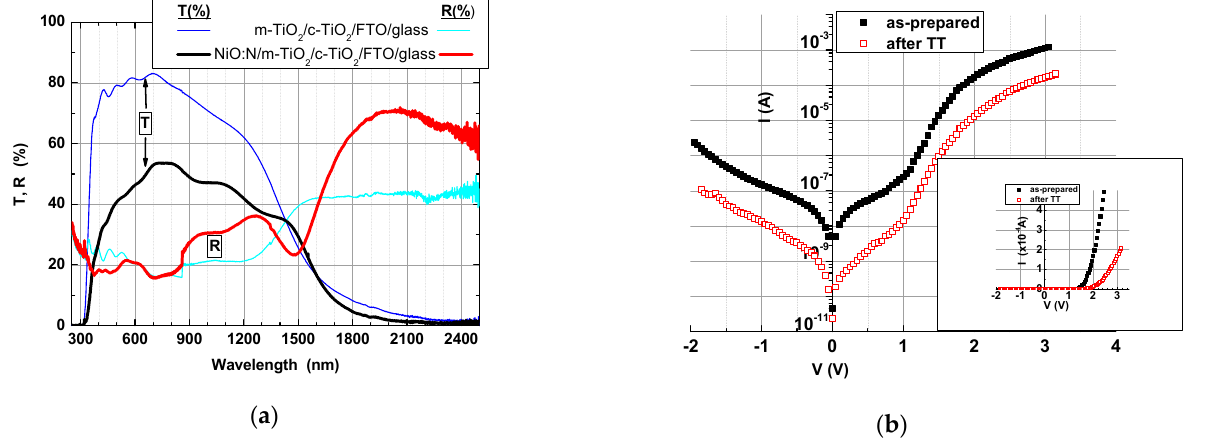
Figure 6. ( a ) UV-Vis-NIR transmittance and reflectance curves of NiO:N/m-TiO 2 /c-TiO 2 /FTO/glass diode and m-TiO 2 /c-TiO 2 /FTO/glass configurations and ( b ) dark I-V curves of NiO:N/m-TiO 2 /c-TiO 2 /FTO diode just after fabrication and after thermal treatment (TT) at 300°C for 15 min in N 2 .